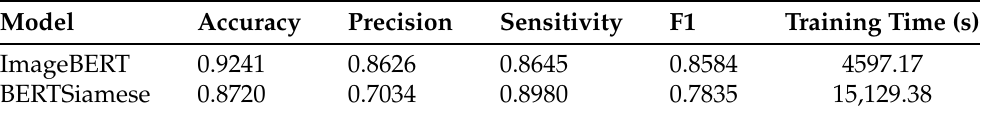
Table 3. Results of multimodal DL